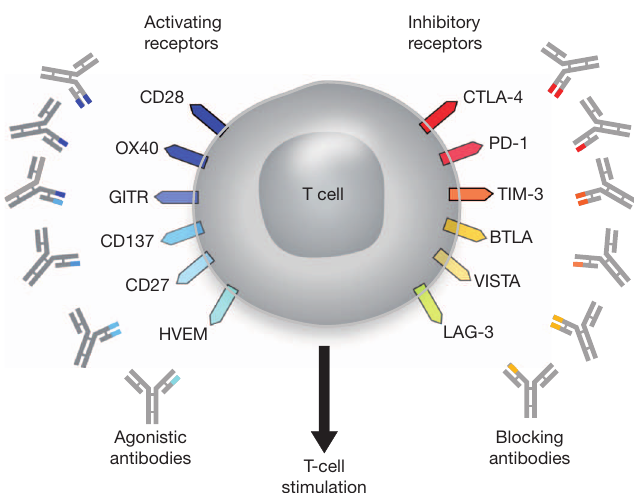
Figure 3. T cell targets for immunoregulatory therapy using antibodies. In addition to specific antigen recognition through the TCR, T-cell activation is regulated through a balance of positive and negative signals provided by co-stimulatory receptors. These surface proteins are typically members of either the TNF receptor or B7 superfamilies. Agonistic antibodies directed against activating co-stimulatory molecules and blocking antibodies against negative co-stimulatory molecules might enhance T-cell stimulation to promote tumor destruction. Reprinted with permission from NPG